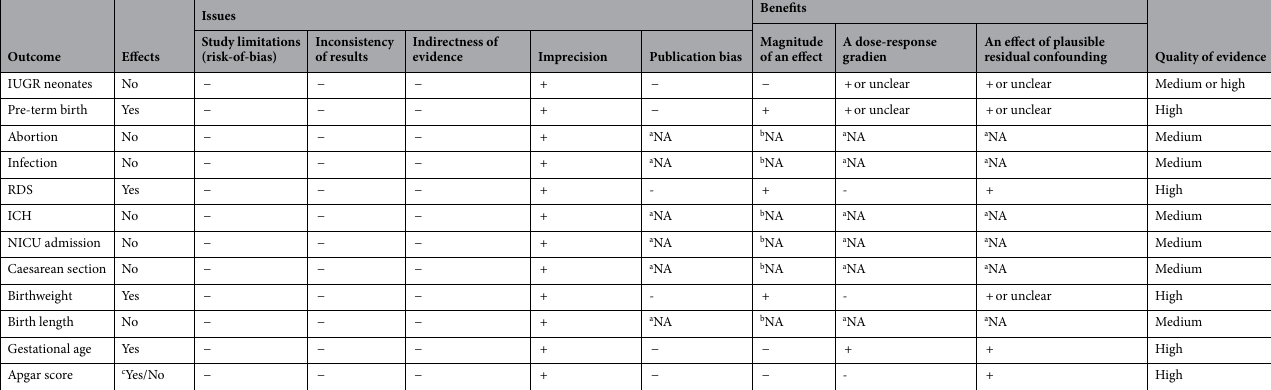
Table 2. Quality of evidence. ICH intracranial hemorrhage; IUGR intrauterine growth retardation; NA not applicable; RDS respiratory distress syndrome. a ”NA” means too small number of studies to allow evaluation of ‘publication bias’ 16 , ‘a dose–response gradient’ 16 and ‘an effect of plausible residual confounding’ 16 . b ”NA” means the irrelevance with ‘magnitude of an effect’ 16 because of no effects on outcomes. c ”Yes” in women at high risk of pre-eclampsia or with pre-eclampsia or gestational or mild chronic hypertension but “No” in the total